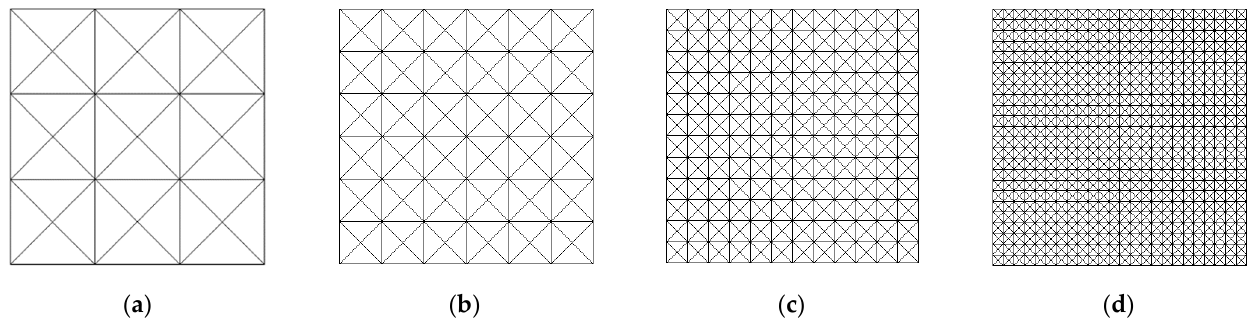
Figure 10. Structured finite element meshes: ( a ) mesh S1 with 36 FE; ( b ) mesh S2 with 144 FE; ( c ) mesh S3 with 576 FE; ( d ) mesh S4 with 2304 FE.